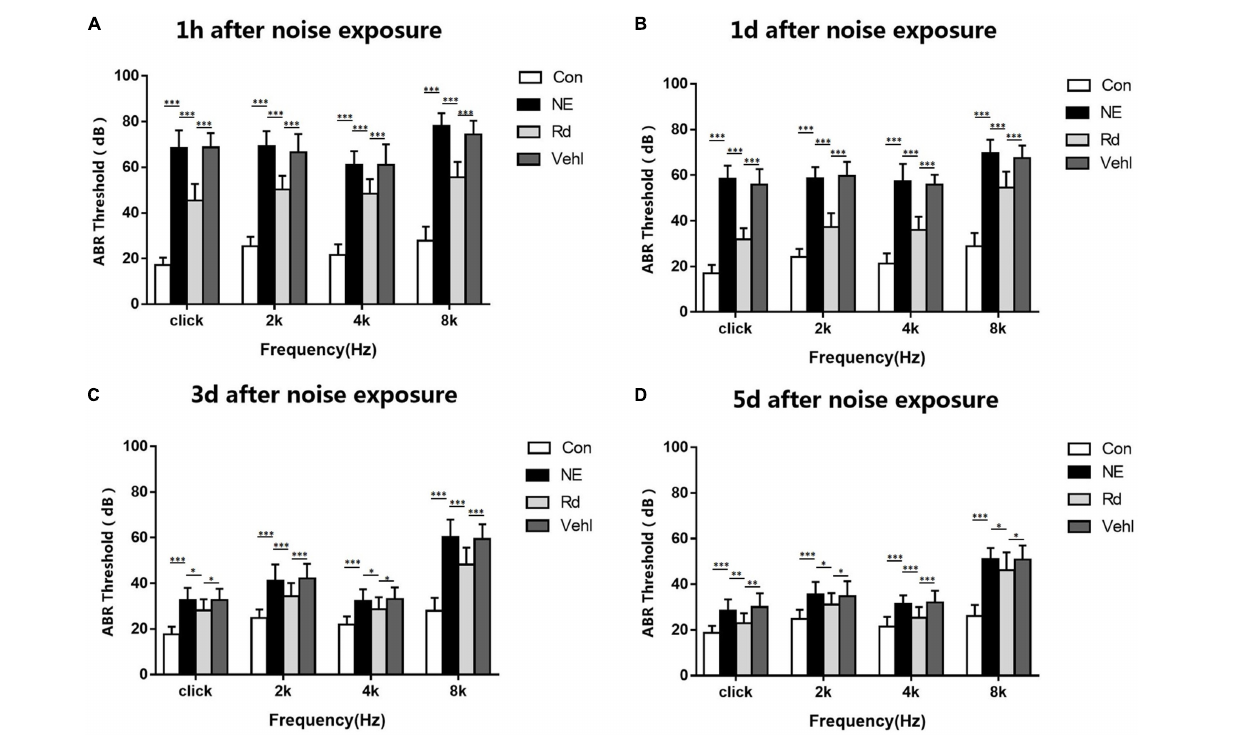
FIGURE 1 | The average ABR threshold values in all groups 1h (A) , 1d (B) , 3d (C) and 5d (D) after 115 dB(A) noise exposure. * p < 0.05, ** p < 0.01, *** p <